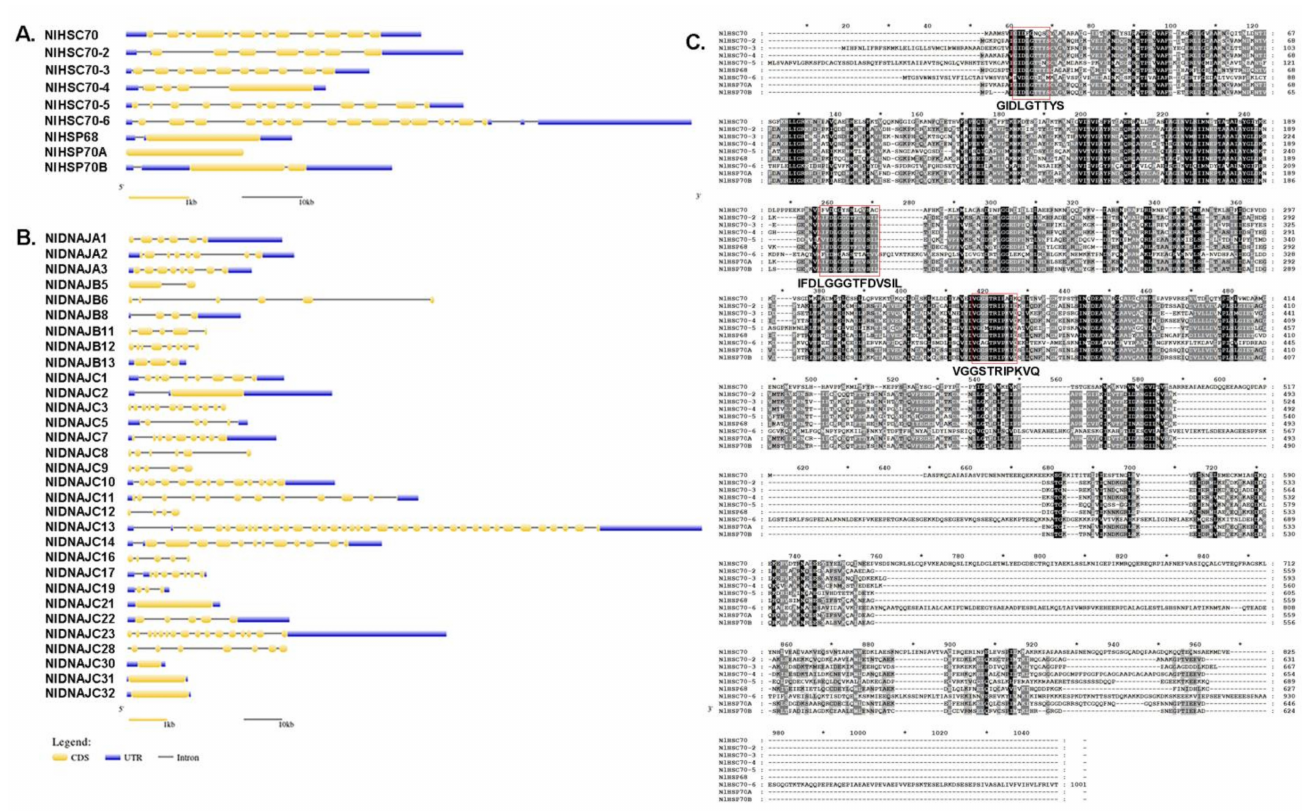
Figure 1. Exon–intron organization of NlHSP70 ( A ) and NlDANJ ( B ) genes. The yellow box, blue box, and gray line represent the coding sequence (CDS), untranslated region, and intron, respectively. ( C ) A full amino acid sequence alignment of NlHSP70 proteins. Identical amino acid residues and conservative substitutions are shaded in black and gray, respectively. HSP70 family signatures are indicated with red